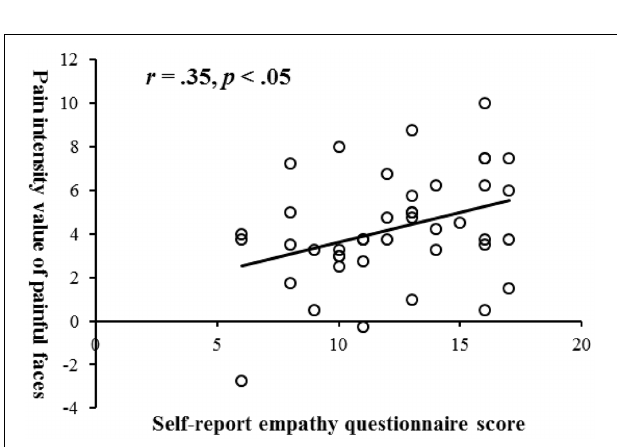
FIGURE 7 | Pain intensity rating scores by type of emotion and empathy.